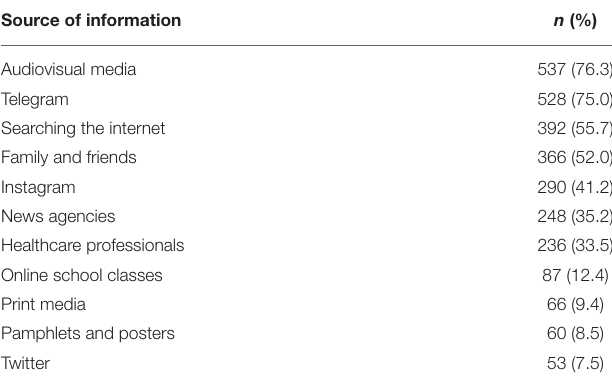
TABLE 4 | Students’ sources of information about